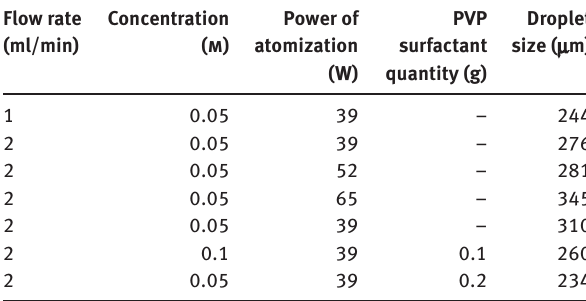
Table 1: Experimentally observed droplet size obtained using ultrasonic